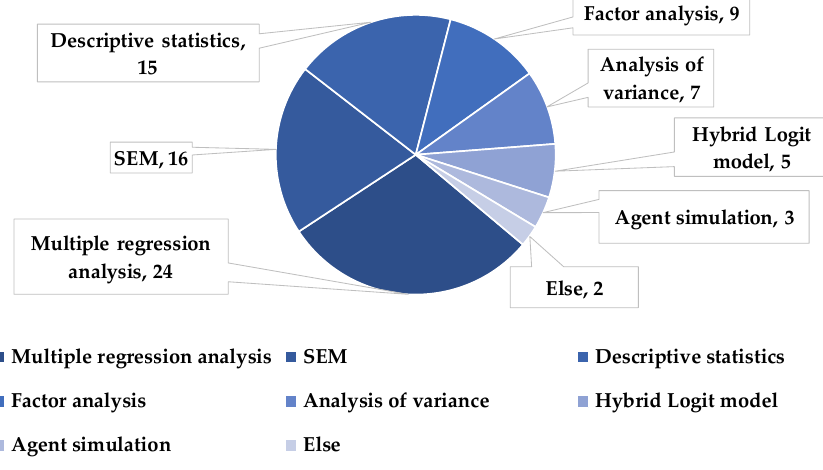
Figure 2. A summary of analysis methods in the literature on autonomous acceptance .